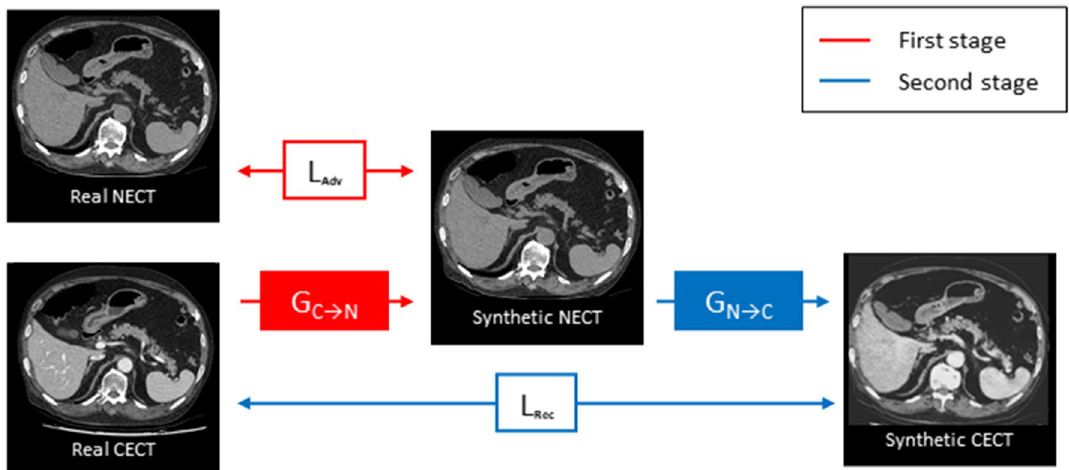
Figure 5. Schematic diagram of the two-stage approach used for making the conversion model. In the first stage, the generator (G C → N ), which generates synthetic NECT from real CECT, is trained adversarially using a conditional generative adversarial network. In the second stage, another generator (G N → C ) that generates synthetic CECT from NECT is trained using a deep convolutional neural network. During the second stage of training, synthetic NECT, which is generated from and perfectly aligned with real CECT, is used as input data, resolving the misregistration issue between input data and ground truth (real CECT). NECT, nonenhanced CT; CECT, contrast-enhanced CT;